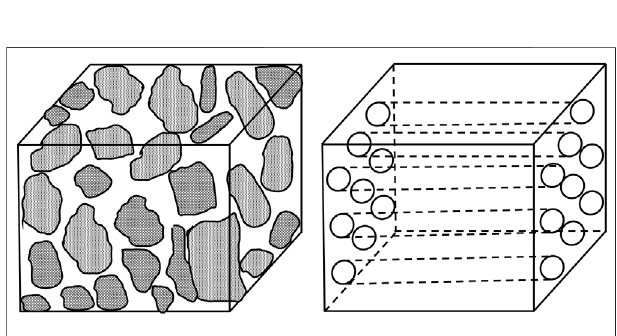
FIGURE 2 | Capillary bundle